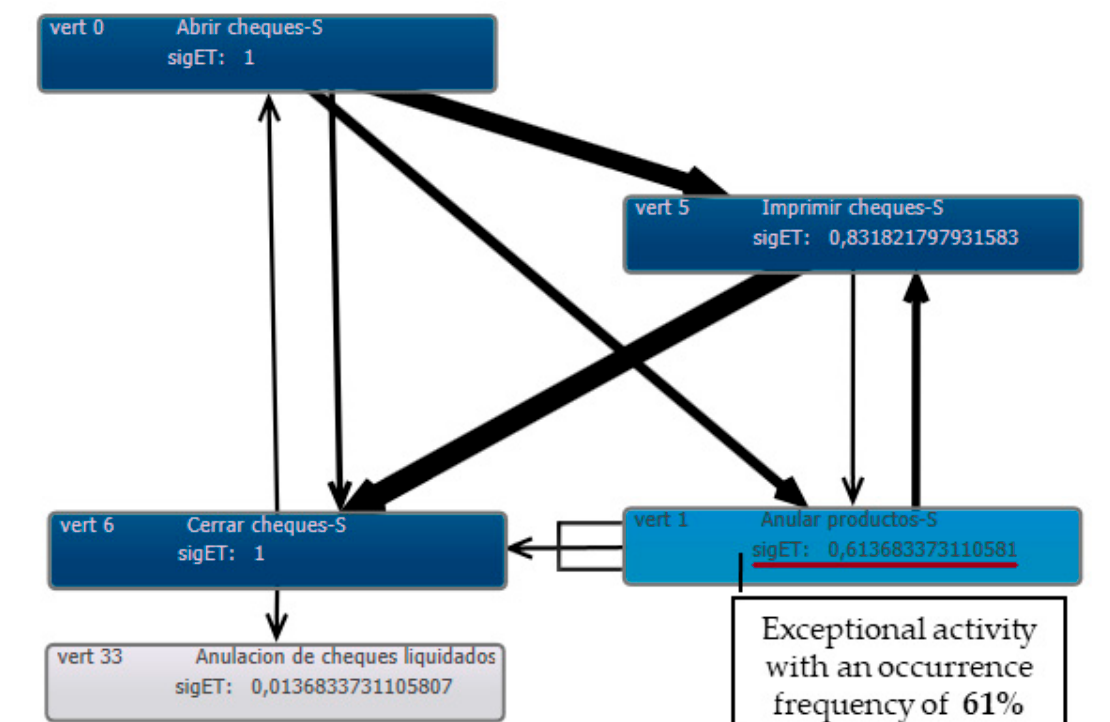
Figure 5. Process model discovered using fuzzy miner. Translation: Abrir cheques (Open Check), Cerrar Cheques (Close Check), Anulación de cheques liquidados (Annul check), Anular productos (Suppress product), and Imprimir cheques (Print check)).